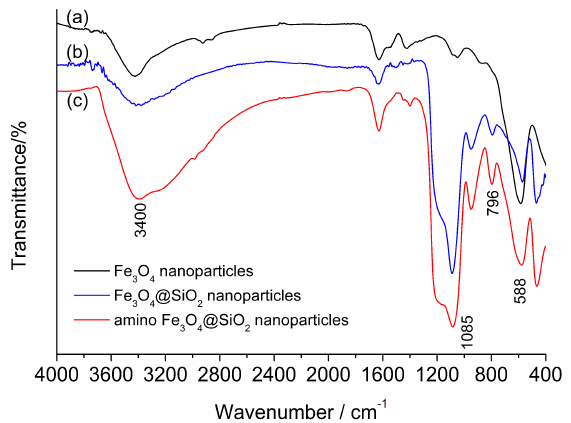
Figure 3. The Fourier transform infrared spectroscopy (FT–IR) spectrum of (a) Fe 3 O 4 nanoparticles, (b) Fe 3 O 4 @SiO 2 nanoparticles and (c) amino Fe 3 O 4 @SiO 2 nanoparticles.